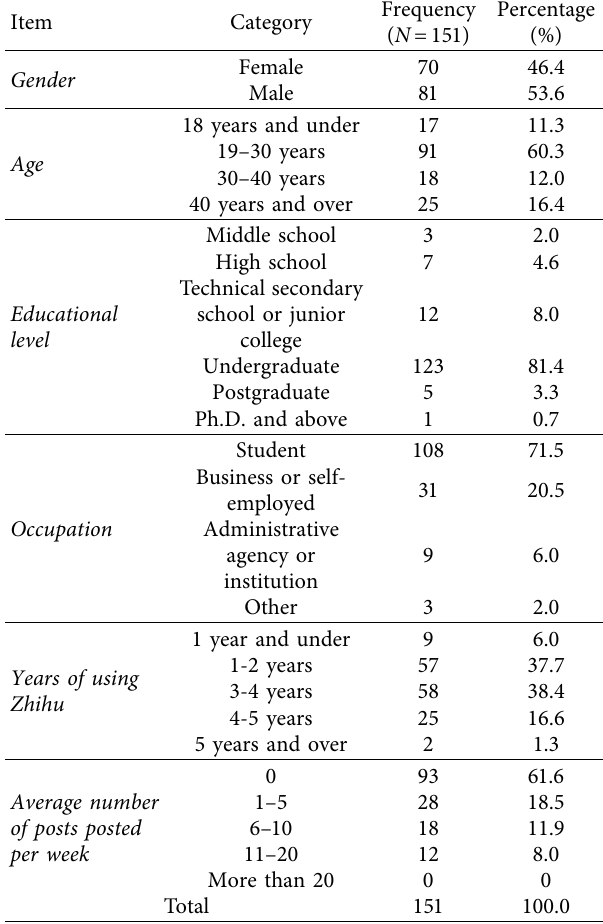
Table 2: Descriptive statistics of knowledge hiding behavior survey.